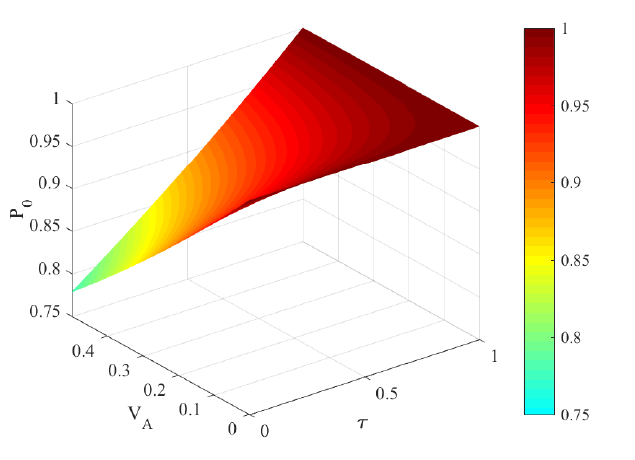
Figure 4. Success probabilities of ZPC with transmittances τ and modulation variance V A